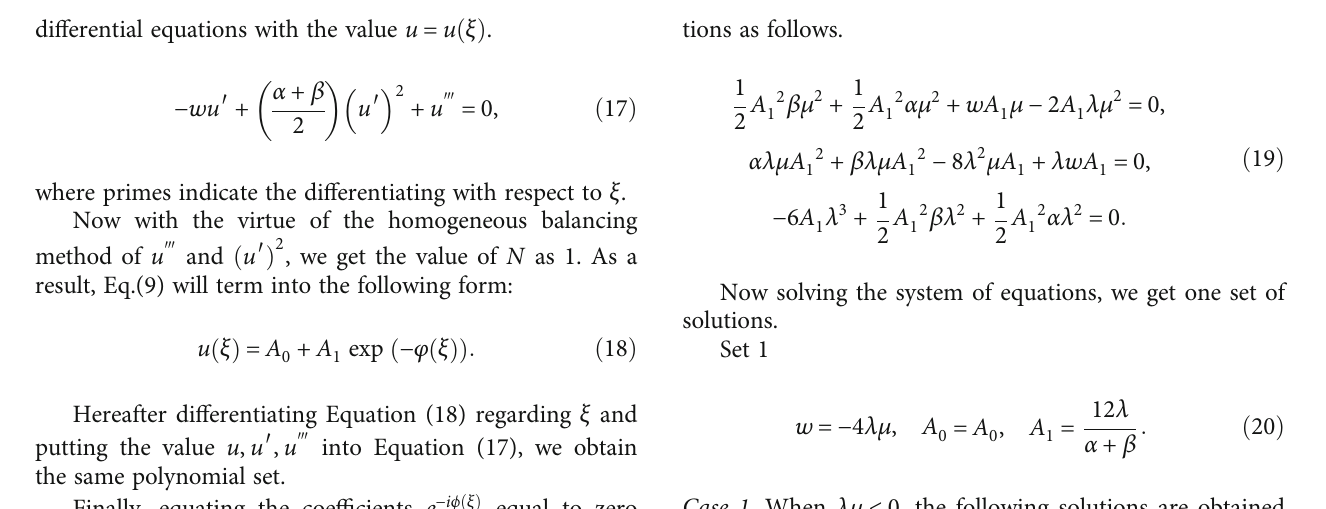
Figure 8: Dynamical behavior of function solution of u